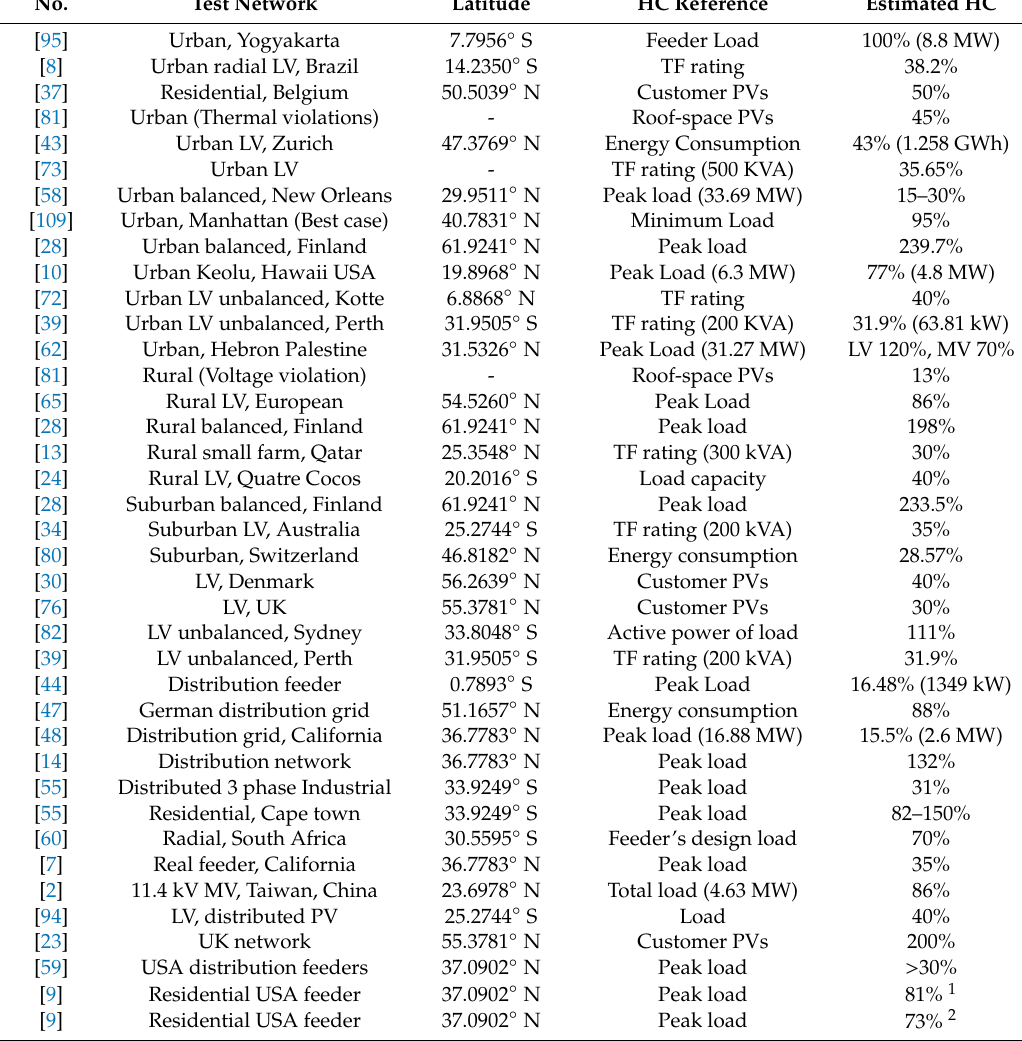
Table 6. Estimated HC of present networks without adopting any control or mitigation